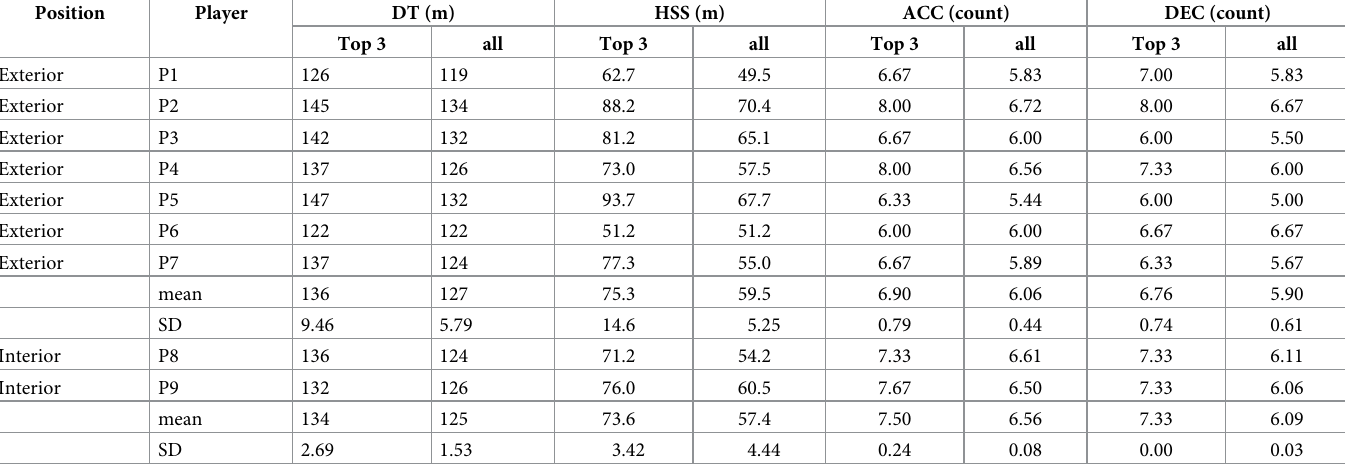
Table 1. Individual reference of the most demanding scenario values for each player extracted from all the games analysed, with the overall means, by position, in 30 s time epochs.